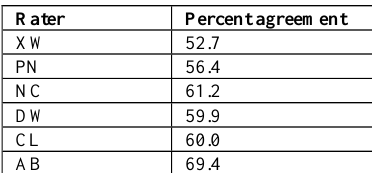
Table A2.1: Rater agreement